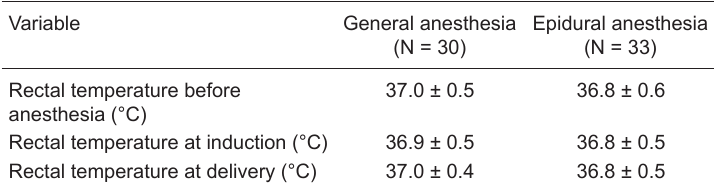
Table 1. Rectal temperatures of pregnant women during cesarean delivery.